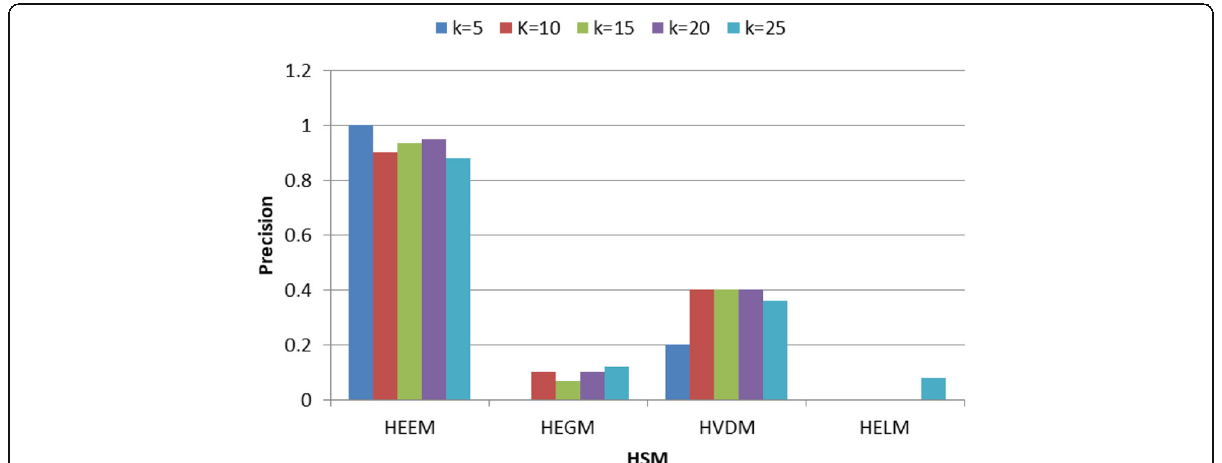
Fig. 2 Precision Score of the heterogeneous similarity metrics (HEEM, HEGM, HVDM, HELM). Precision of the heterogeneous similarity metrics (HSM) measures how many relevant cloud services were ranked and returned by HSM as contained in the gold standard. The gold standard contained the ranking of services produced by HEOM, and it served as the benchmark to measure the precision of the rankings produced by other HSM including HEEM, HEGM, HVDM and HELM. The value of top-k ranged from 5, 10, 15, 20 and 25. HEEM had the highest precision score on all values of k compared to other